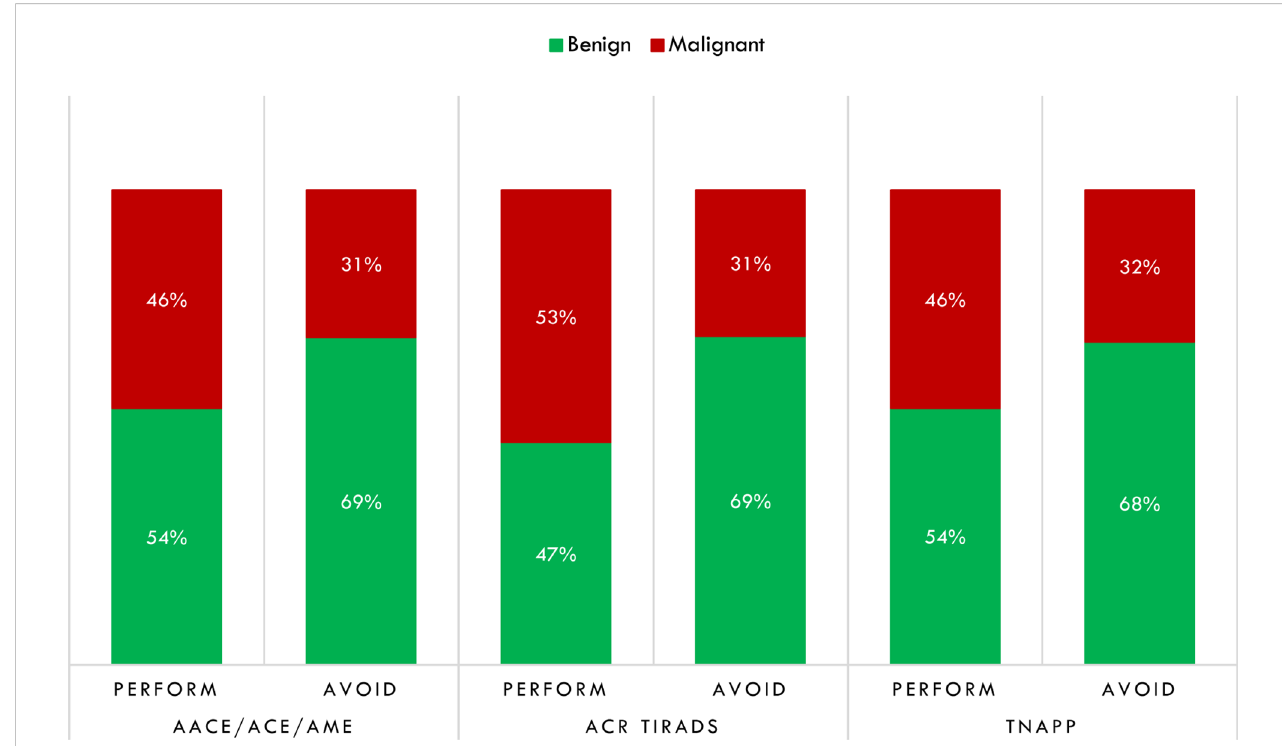
FIGURE 5 Distribution of thyroid biopsies that would have been performed or avoided regarding thyroid histology after dichotomizing histological results in non- malignant (benign) and malignant. AACE/ACE/AME, American Association of Clinical Endocrinology/American College of Endocrinology/Associazione Medici Endocrinologi; ACR TI-RADS, American College of Radiology Thyroid Imaging Reporting and Data System; TNAPP, Thyroid Nodule